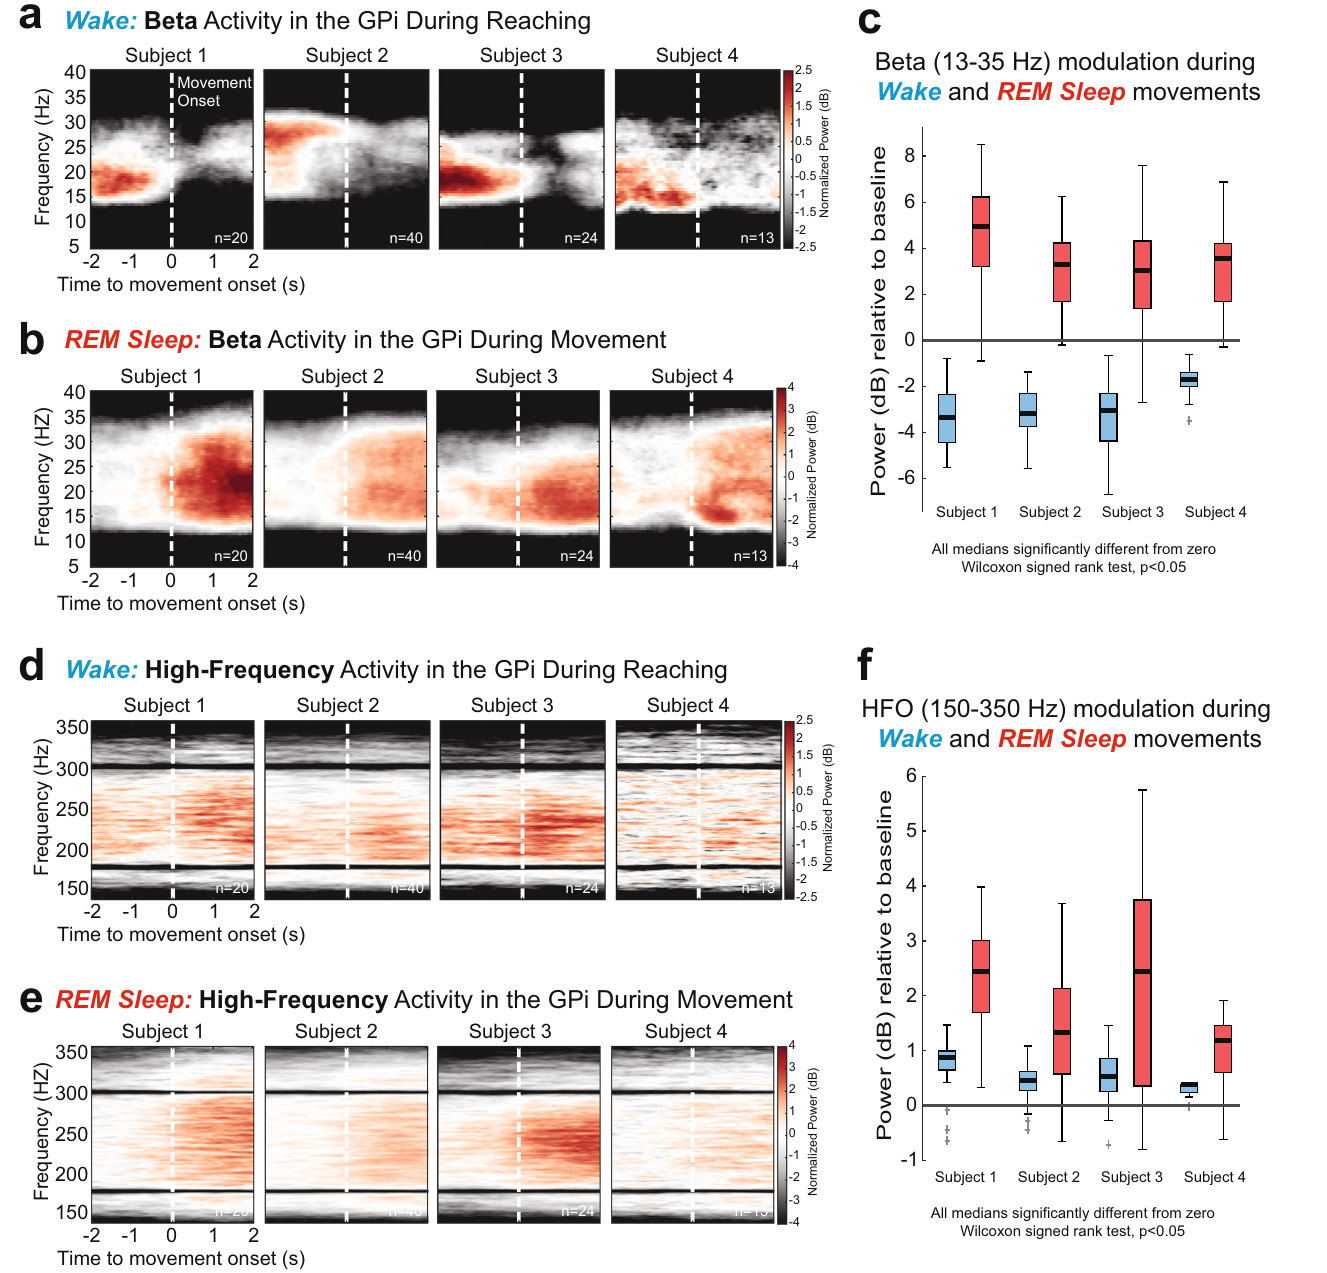
Fig. 1 Movement-related beta and high-frequency oscillations recorded from DBS leads in the GPi of PD patients in awake and REM sleep states. a Trial-averaged spectrograms aligned to movement onset showing beta (13 – 35 Hz) desynchronization in the GPi during wakeful volitional movement (reaching task, see Methods). b Spectrograms showing beta synchronization in the GPi during REM sleep movements. c Distributions of beta band power modulation (relative to pre movement baseline) during wake movements (blue) and REM sleep movements (red). All data distributions were signi fi cantly different from zero (Wilcoxon signed rank (WSR) test, p < 0.05). d , e Trial-averaged spectrograms aligned to movement onset show synchronization of high-frequency oscillations (HFO, 150 – 350 Hz) in the GPi during wakeful and REM sleep movements, respectively. f Distributions of HFO band power modulation (relative to pre movement baseline) during wake movements (blue) and REM sleep movements (red). All data distributions were signi fi cantly different from zero (WSR test, p < 0.05). Boxplot elements: center line, median; box limits, upper and lower quartiles; whiskers, 1.5 × interquartile range; + sign,